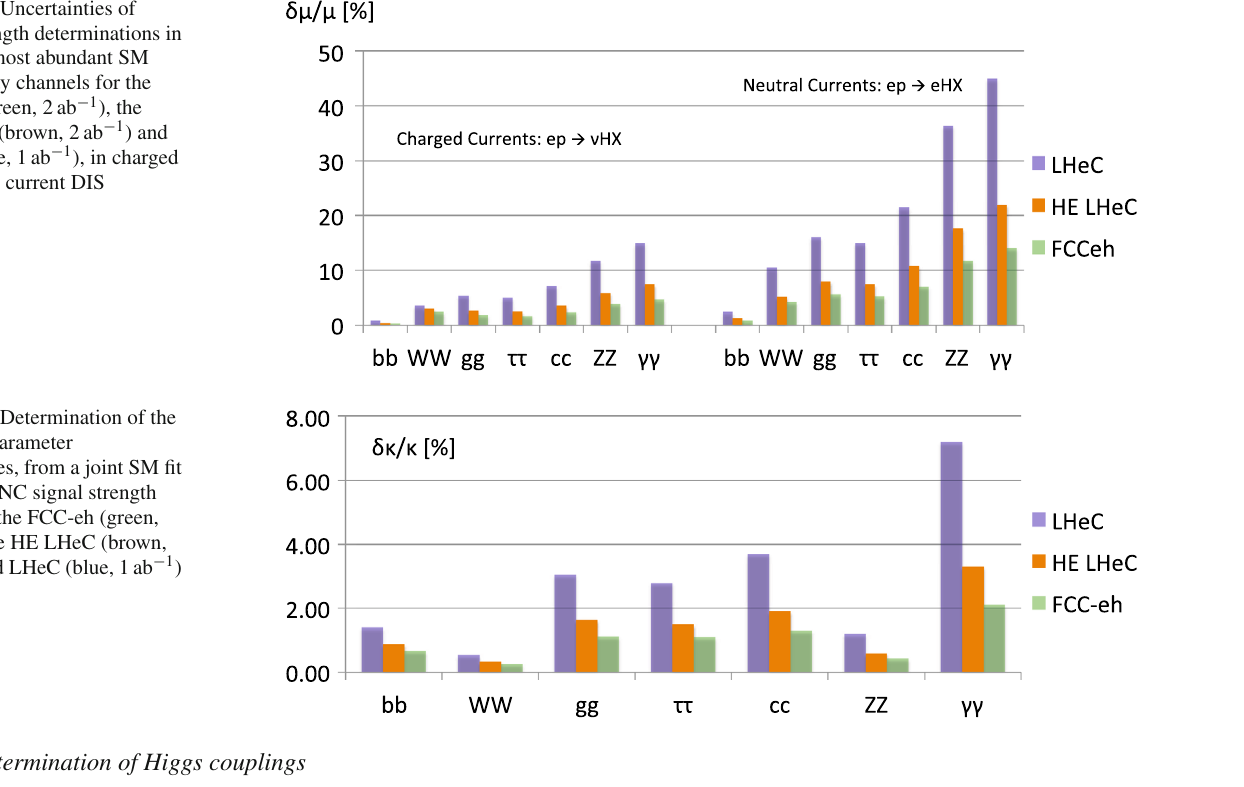
Fig. 4.11 Uncertainties of signal strength determinations in the seven most abundant SM Higgs decay channels for the FCC-eh (green, 2ab − 1 ), the HE-LHeC (brown, 2ab − 1 ) and LHeC (blue, 1ab − 1 ), in charged and neutral current DIS production